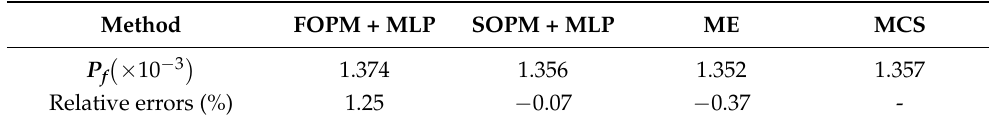
Table 7. Comparison of the failure probabilities for Example